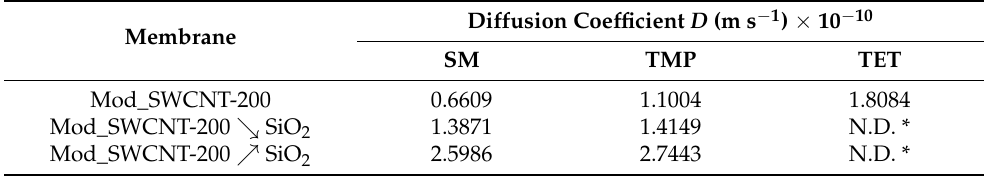
Table 10. Diffusion coefficients of SM, TMP, and TET transport through the selected membranes.